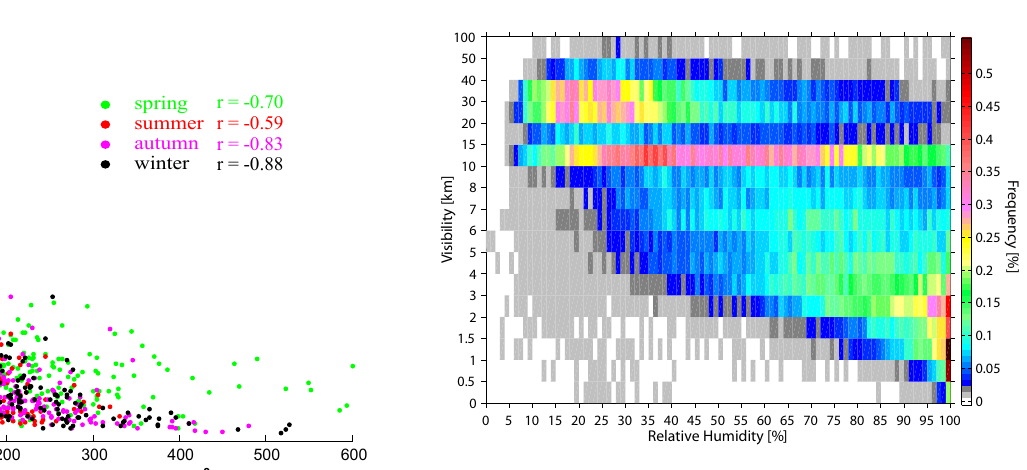
Fig. 6. Hourly occurrence frequency of visibility in relation to visi- bility and RH in BCIA from 1999 to